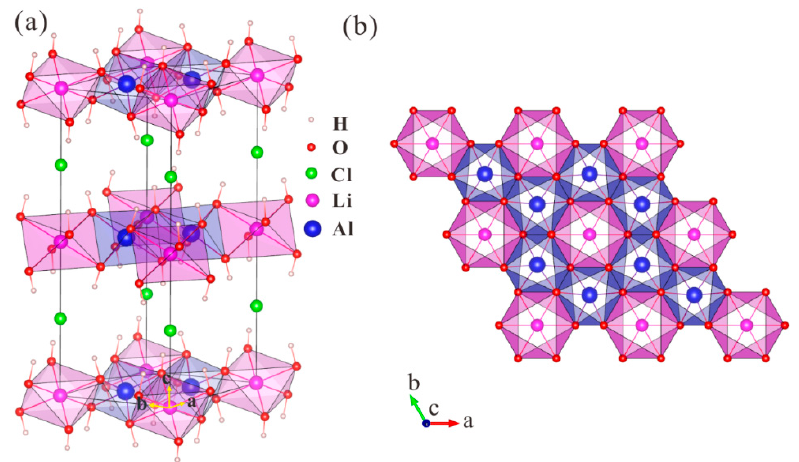
Figure 1. ( a ) Crystal structure of LiAl 2 (OH) 6 Cl with LiO 6 and AlO 6 octahedra indicated; ( b ) projection of a LiAl 2 O 6 layer along the [001] direction.